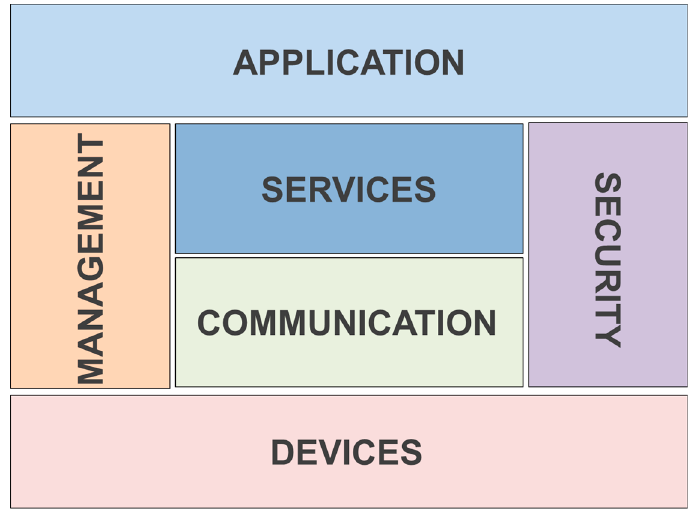
Figure 30. Architecture proposal for an IoT irrigation system for agriculture.